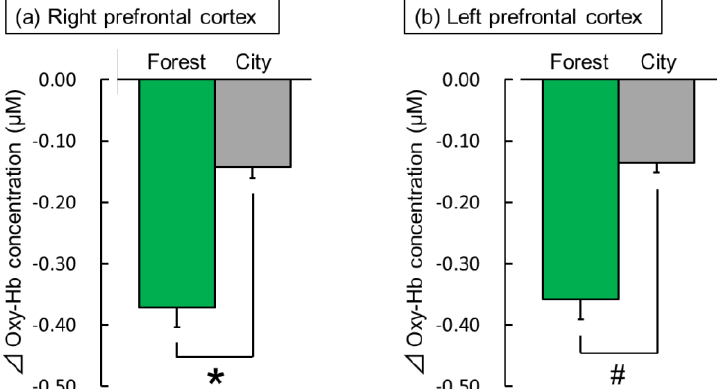
Figure 4. The overall mean oxyhemoglobin (oxy-Hb) concentrations in the right ( a ) and left ( b ) prefrontal cortex during exposure to the forest vs. city sounds. Data are expressed as mean ± standard error (n = 29). * p < 0.05, # p < 0.07 as determined by paired t -test (one sided).